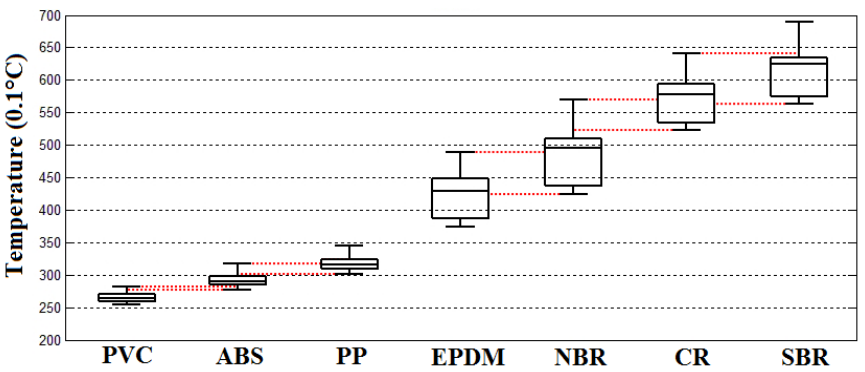
Figure 14. Distribution of temperature rises on tested polymer samples under microwave irradiation power of 9 kW.